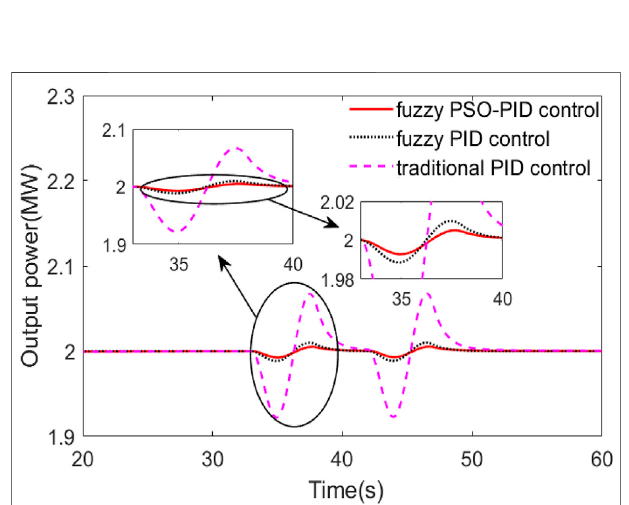
FIGURE 15 | Comparison curves of wind wheel speed under turbulent